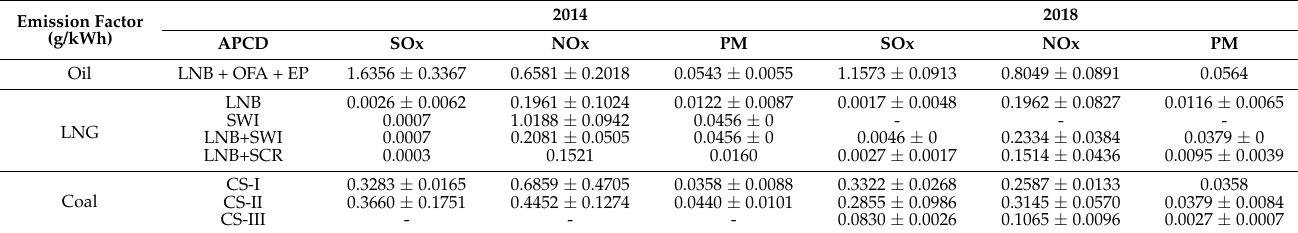
Table 3. Air pollutant emission factors (g/kWh) for the fossil-fuel power generation sector in Taiwan. Emission Factor